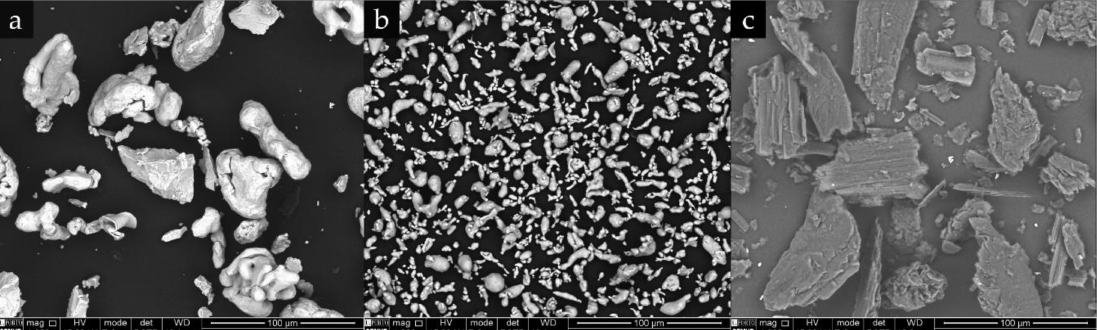
Figure 3. SEM-backscattered electron (BSE) images showing the morphology of the starting powders: